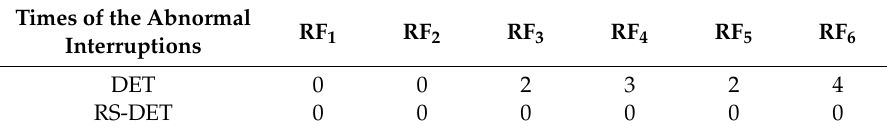
Table 8. The abnormal interruptions in the DET and the RS-DET. Times of the Abnormal